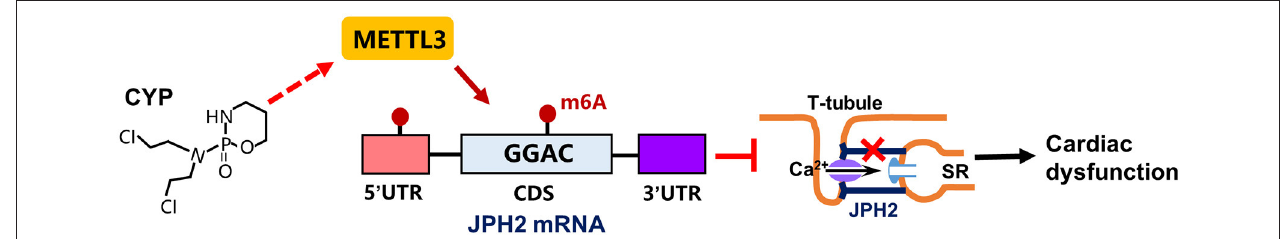
FIGURE 8 | Schematic of CYP-induced cardiac electrical and mechanical alterations. CYP decreased JPH2 expression by upregulating METTL3 expression, leading to Ca 2 + transient irregularities and cardiac